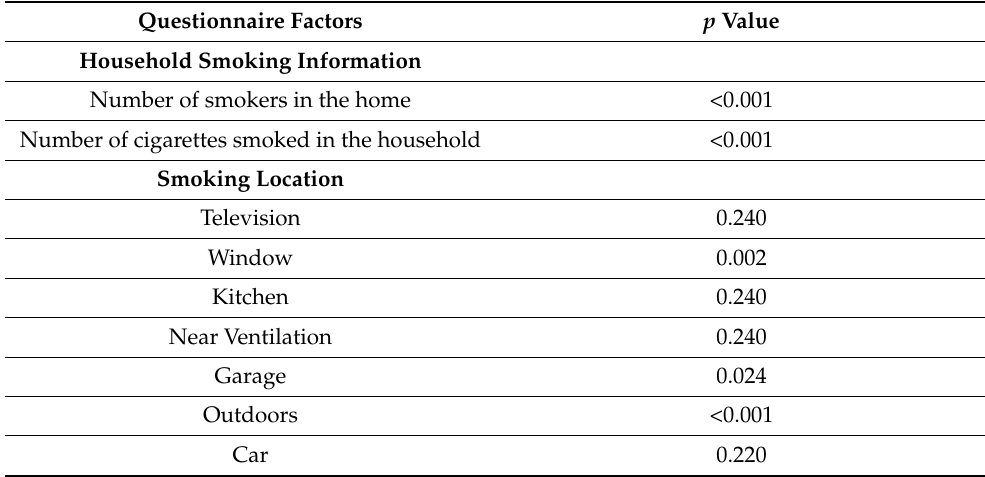
Table 4. Bivariate analysis of associations between tobacco exposure questionnaire factors and meeting the CCR